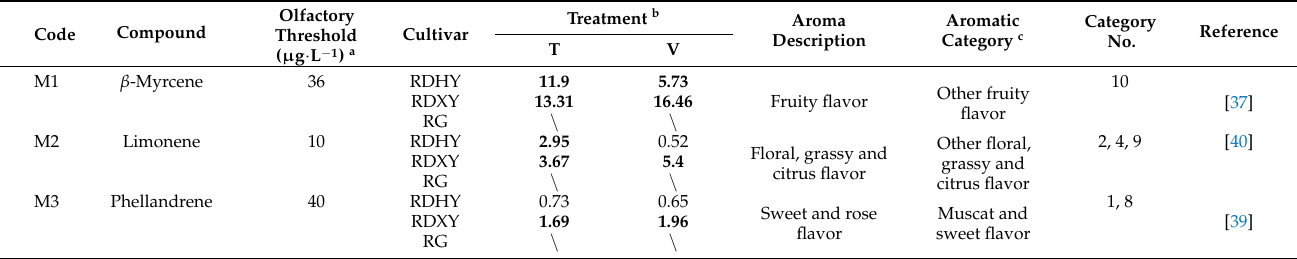
Table 4. OAV and aromatic descriptions of monoterpenes in three table grape cultivars under two trellis systems. (a) The threshold refers to the following literature [31–39]. (b) Bold results for OAV indicate that the value is greater than 1. (c) The medium is a water solution, with the aromatic categories: 1-muscat, 2-grassy, 3-lemon, 4-citrus, 5-mint, 6-mushroom, 7-fat, 8-sweet, 9-other floral, and 10-other fruity.